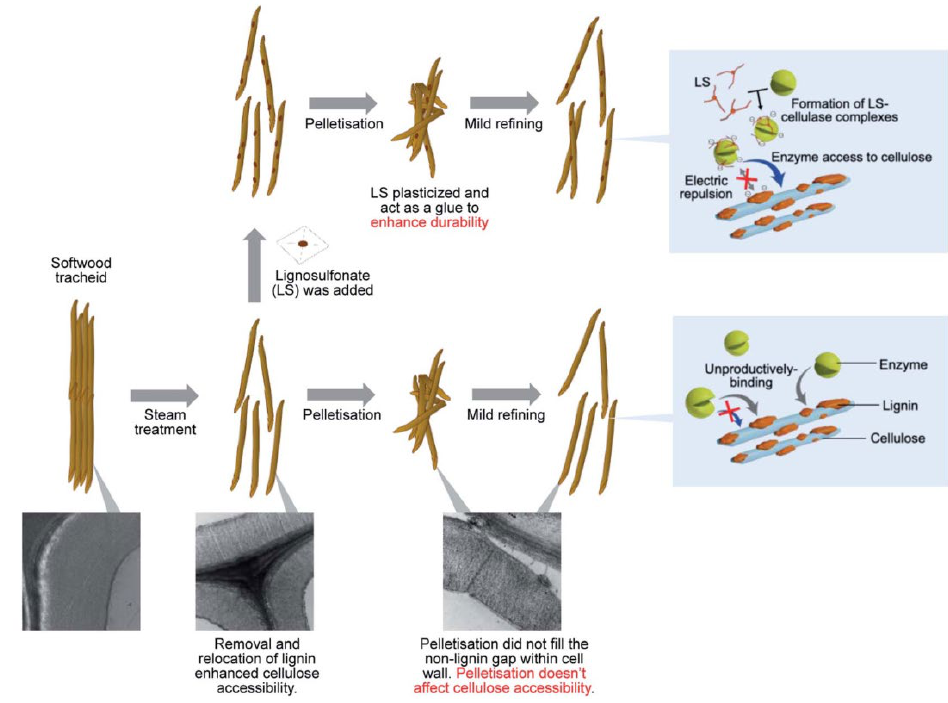
Figure 4. The influence of steaming, pelletization and lignosulfonate addition on pellet durability and cellulose hydrolysis. Adapted with permission from Ref. [80]. 2020, Royal Society of Chemistry.